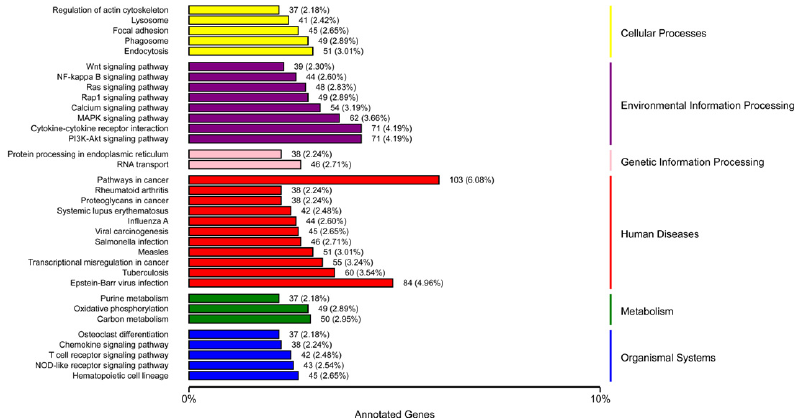
Figure 6. Results of Gene Ontology (GO) enrichment are classified according to different functions. DEGs and all genes are distinguished between dark and light colors, while percentages of genes are represented by histograms.